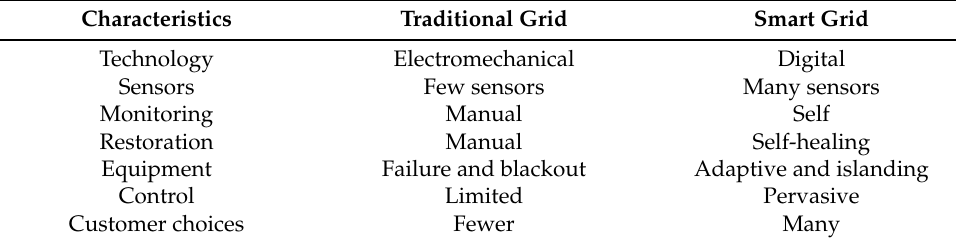
Figure 4. Smart grid—general example. Table 1. Comparison between traditional and smart